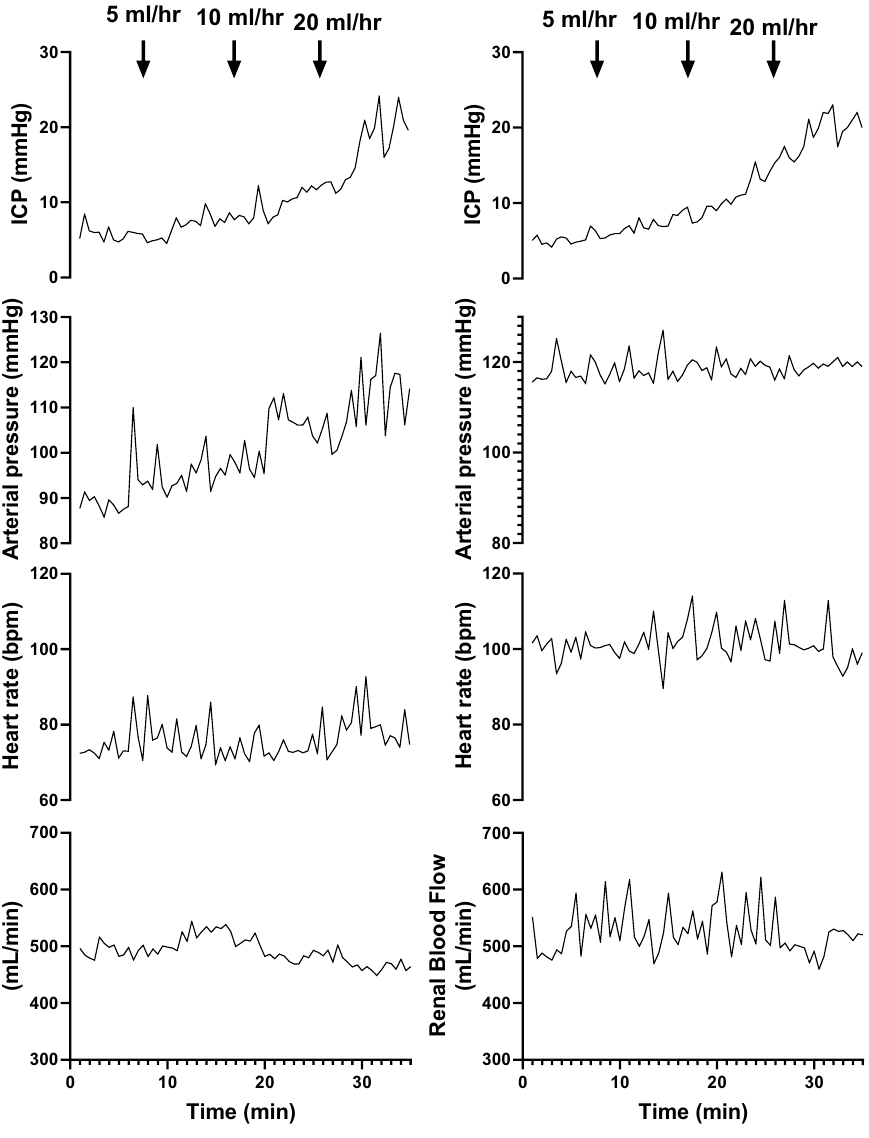
Figure 1. Representative example of intracranial pressure (ICP), arterial pressure, heart rate and renal blood flow showing the temporal nature of the response when ICV saline is infused in one normotensive (left) and one hypertensive (right) animal. Arrows show the start of each infusion